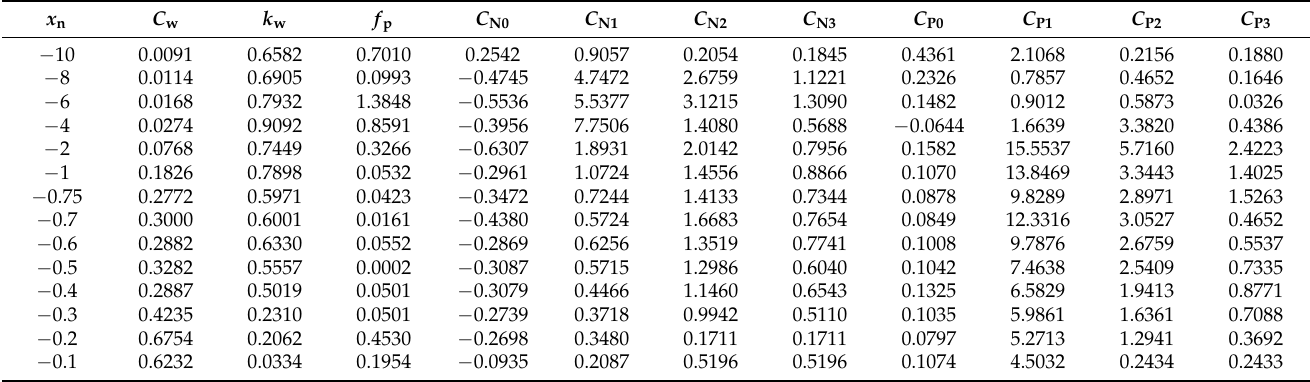
Table A1. The fitting parameters in the ultra-super-Gaussian function, f USG , ( x n < 0).